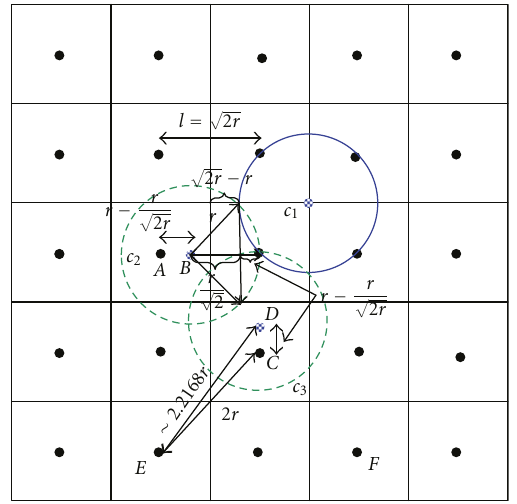
Figure 6: Compensating for the lack of coverage in static cells.